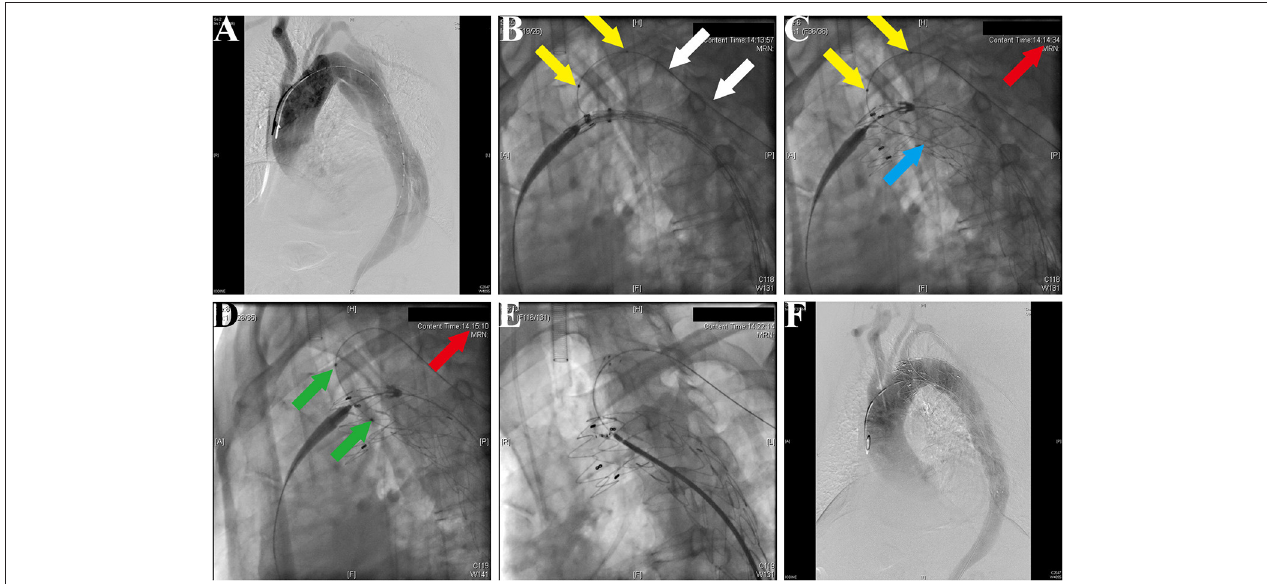
FIGURE 3 | Fluoroscopic demonstration of the fenestrated stent graft delivery and engagement. (A) Morphological feature of aortic dissection through the digital subtraction angiography. (B) Delivery and advancing of the main stent graft into the proper landing zone. A traction guidewire was established through the left subclavian artery (LSCA) (white arrows). An angioplasty balloon catheter was prepared for the expansion of the fenestration (yellow arrows). (C) The main stent graft was released and the LSCA was temporarily covered. The traction guidewire was still in the stent graft (blue arrow). (D) Angioplasty of the LSCA through the guidewire from left brachial access (green arrows). The duration from coverage of the LSCA and revascularization was 36s (red arrows, 14:14:34–14:15:10). (E) Deployment and engagement of the LSCA branch stent graft. (F) Final aortogram demonstrating patent arch branches and exclusion of the false